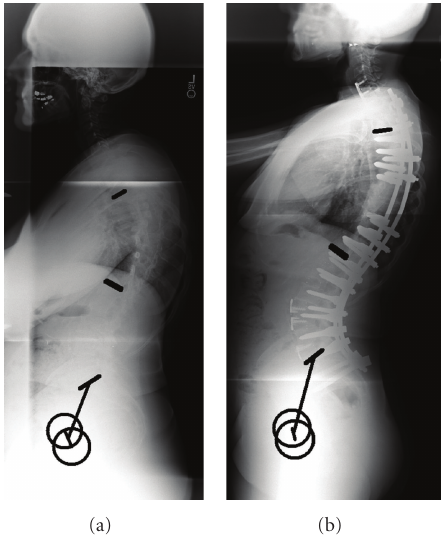
Figure 5: Thoracic resection, extended fusion to the lumbar